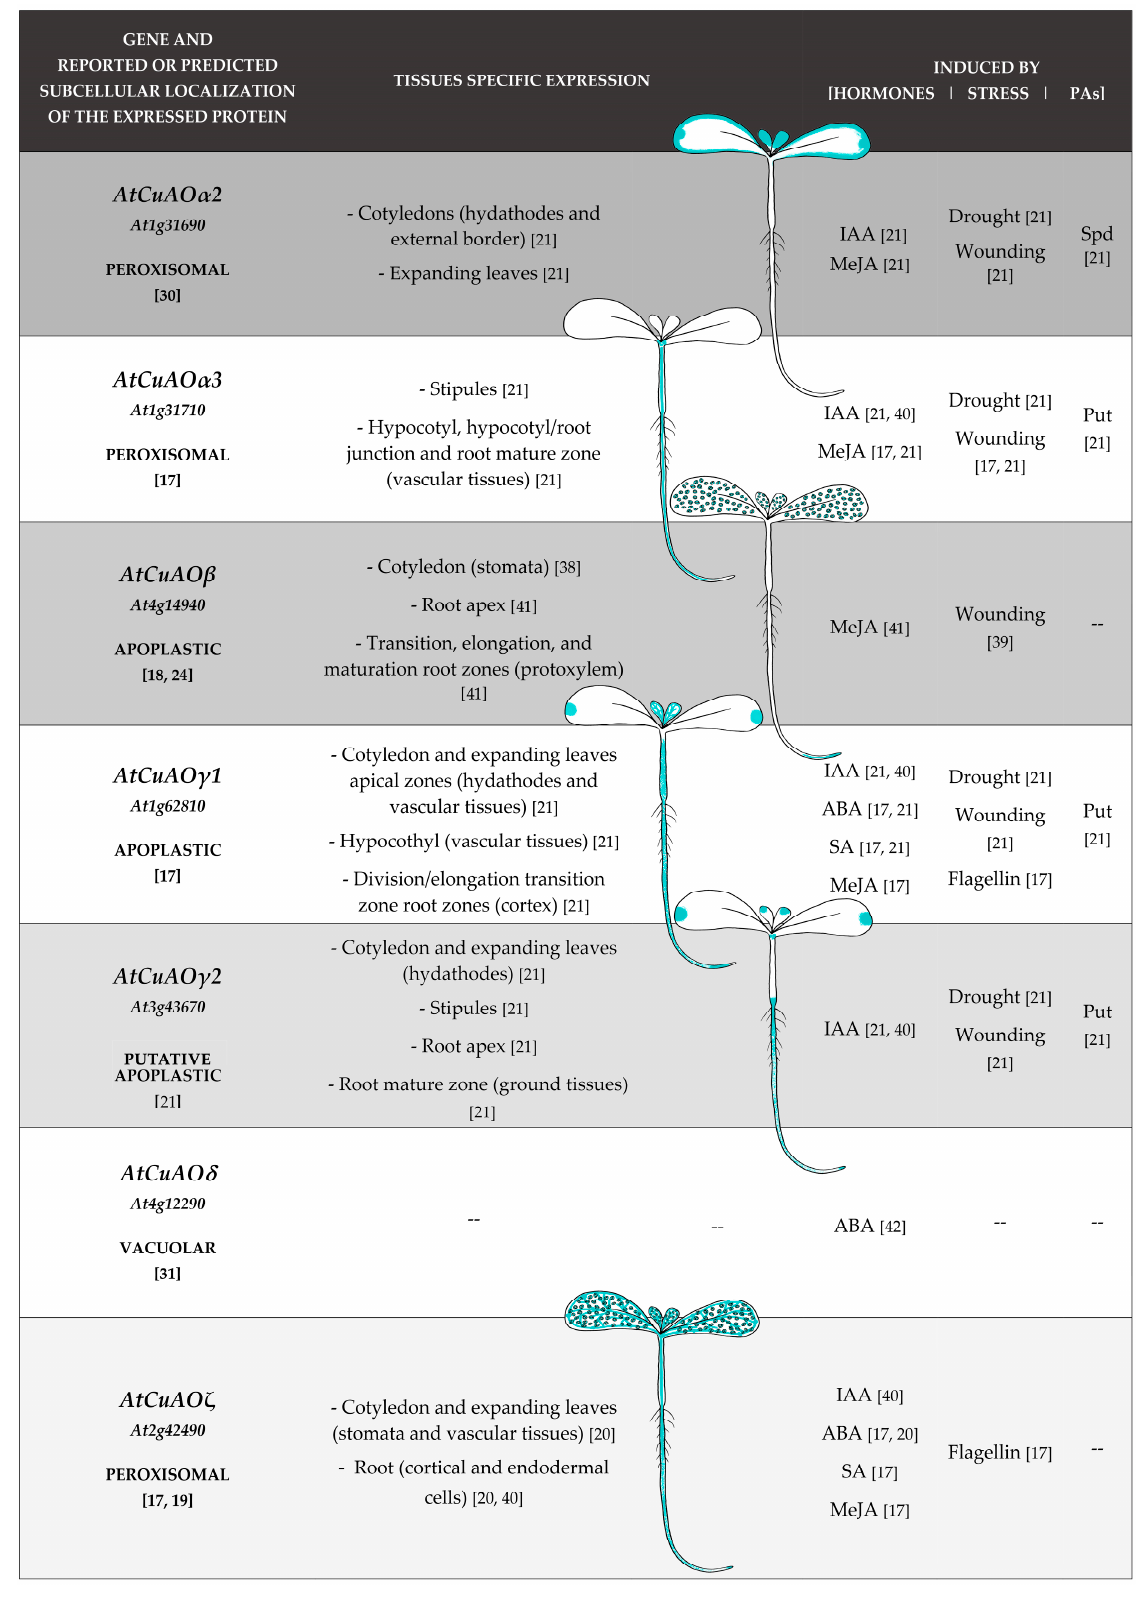
Figure 1. Schematic representation of transcriptional activity of CuAO promoters in organs/tissues of Arabidopsis plantlets and induction by stress, stress-related hormones and PAs.